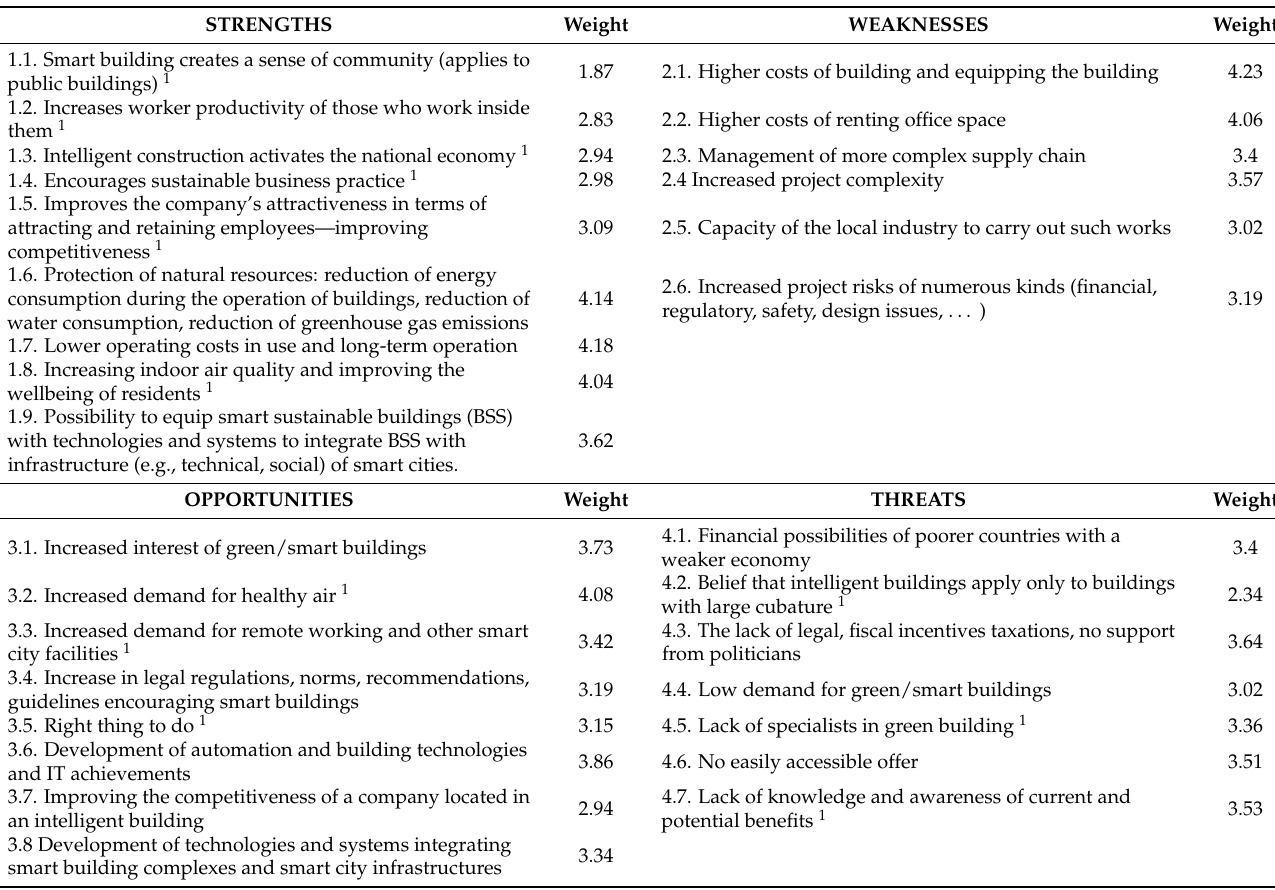
Table 1. SWOT matrix of smart sustainable